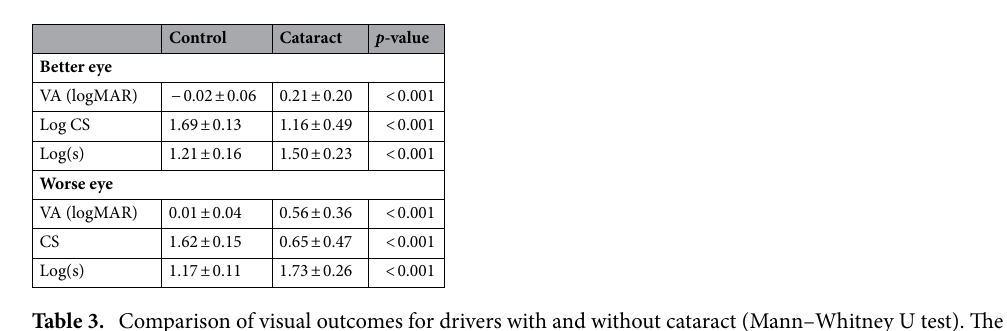
Table 3. Comparison of visual outcomes for drivers with and without cataract (Mann–Whitney U test). The worse and better eye were defined according to visual